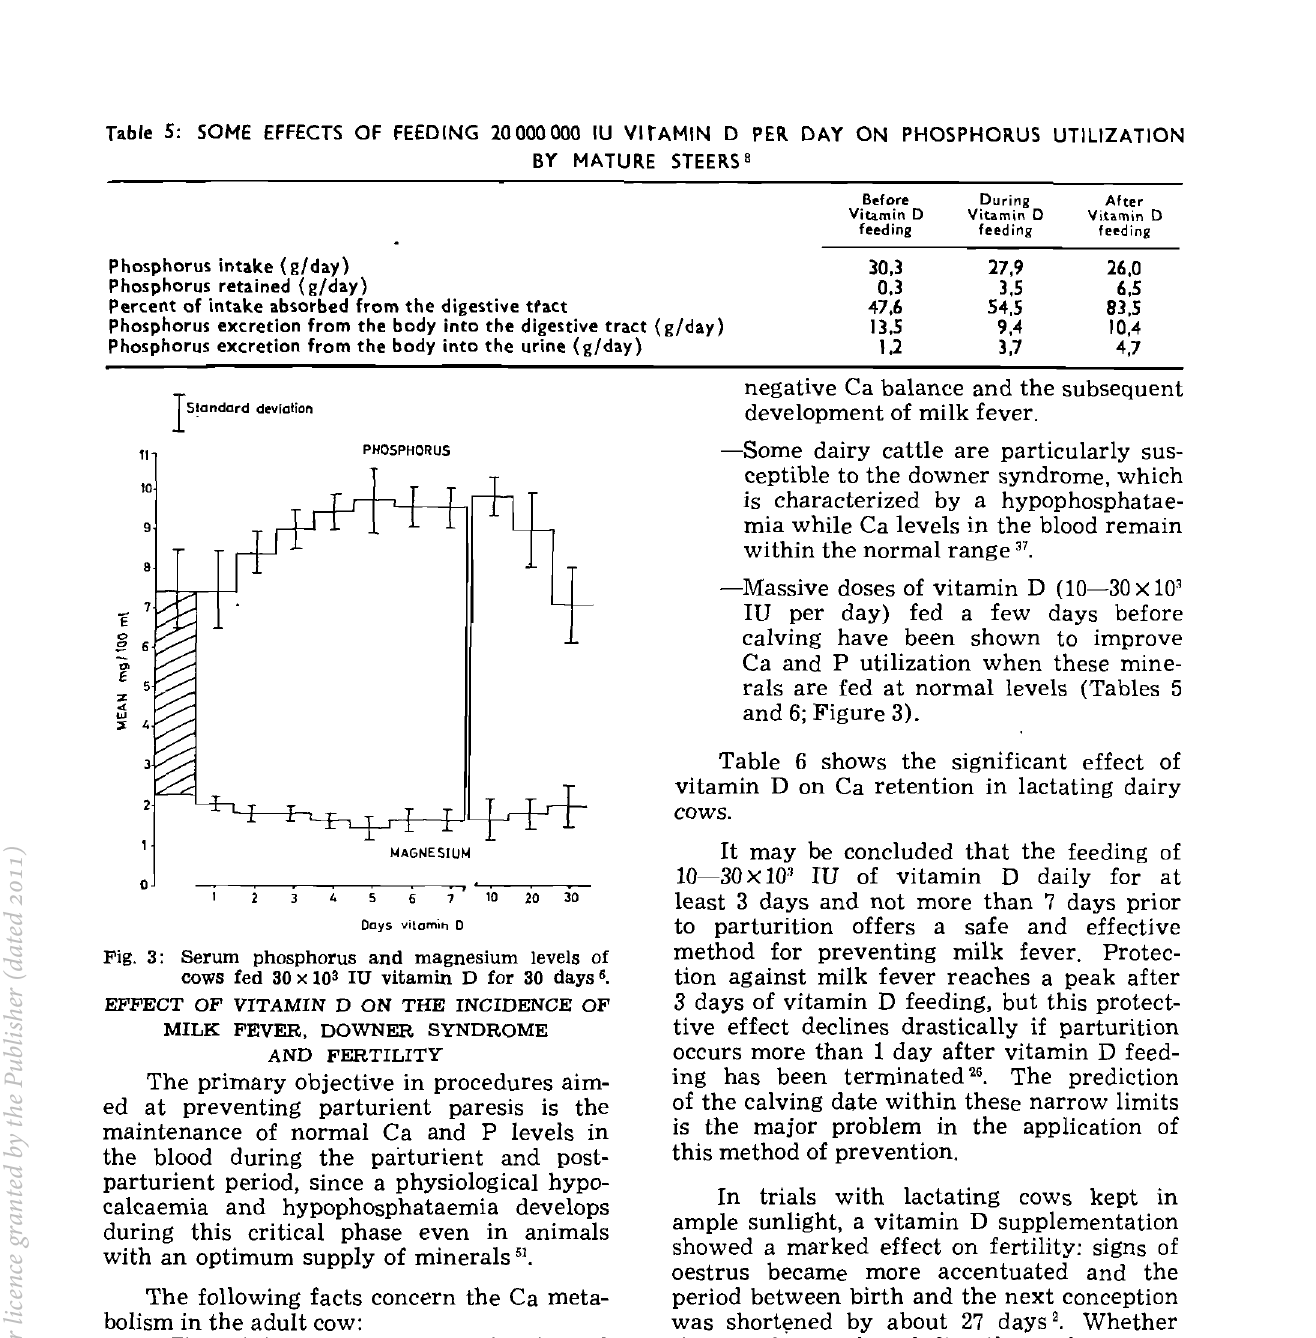
Fig. 3: Serum phosphorus and magnesium levels of cows fed 30 x 10 3 IU vitamin D for 30 days 6. EFFECT OF VITAMIN D ON THE INCIDENCE OF MILK FEVER, DOWNER SYNDROME AND